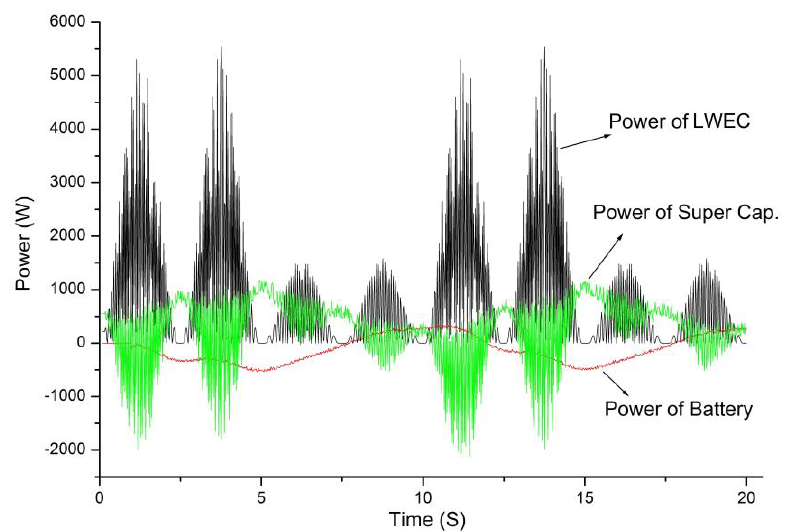
Figure 14. Power of battery and super capacitor responding to the power variation of a LWEC.